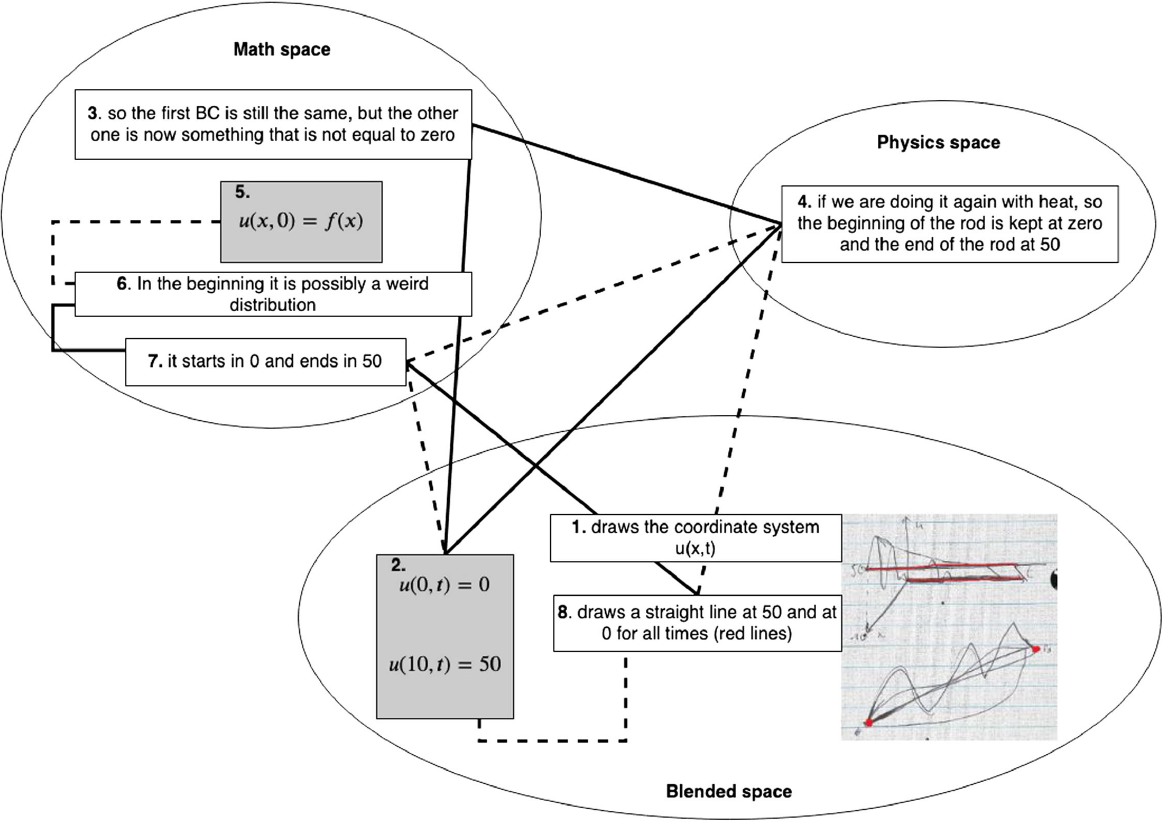
FIG. 9. DBD 1: David and Evan ’ s answer to question B-I. At this point in the transcript, the students only construct parts of the sketch. Top sketch: the coordinate system and the two horizontal lines starting at (10, 50) and (0, 0). Bottom sketch: the two dots on the sides (at 0 and